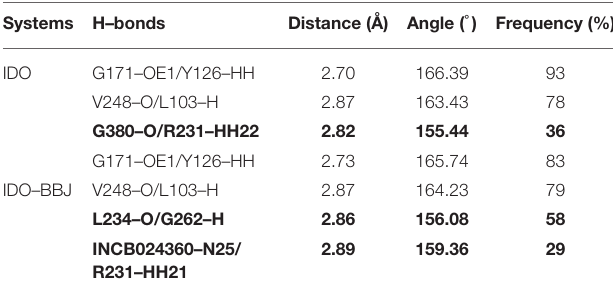
TABLE 2 | The hydrogen bonds around pockets of IDO and IDO–BBJ systems during MD simulation. Systems